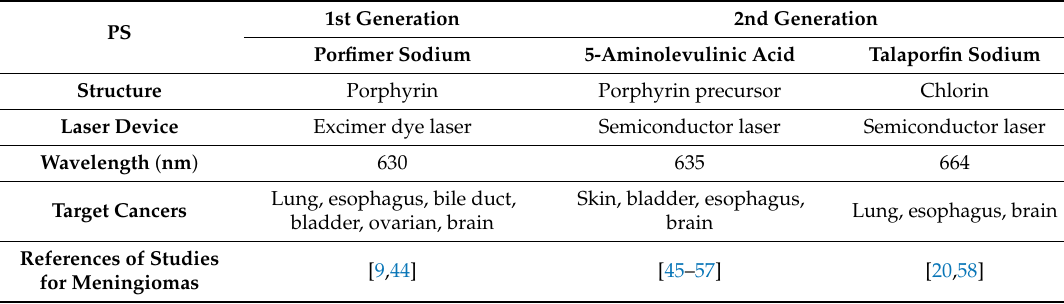
Figure 3. Structures of representative PSs: Porphyrins are a group of heterocyclic macrocycle organic compounds, composed of four modified pyrrole subunits interconnected at their α carbon atoms via methine bridges. Table 2. Photosensitizers (PSs) clinically approved for photodynamic therapy